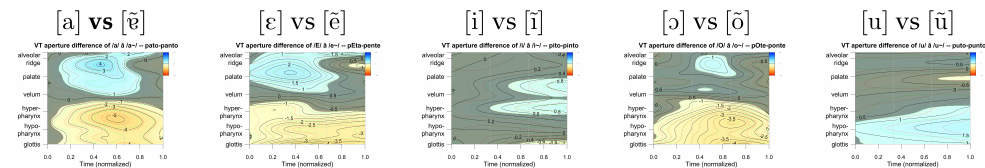
Figure 4. From left to right, comparison between vowels [a, E , i, O , u] and their nasal counterparts as produced for the second prosodic condition. The images show the difference between the cor- responding ‘areagrams’ and are analogous to those presented in the rightmost column in Figure 3 (corresponding to the first prosodic condition). A comparison between the two figures shows a similar difference pattern between orals and their nasal counterparts for the two prosodic conditions. In these representations, shades of blue represent positive values, shades of red stand for negative values, and the gray areas mean that the compared GAMMs are